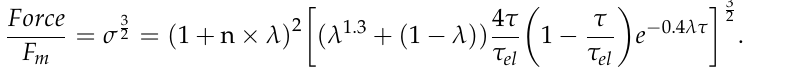
Figure 9. ( a ) Force–time collision curves of the equation established in this study and that of the Zener standard; ( b ) Force–time collision curves of the equations established by Boettcher et al. and Zener standard [2,12]. 4. Conclusions The nonlinear collision motion equation proposed by Zener [2] is the force–time col- lision curve of the inelasticity parameter ( 0 (cid:3409) λ (cid:3409) 1.5 ) considered in the collision process through numerical analysis. In this study, we have proposed an approximate solution to Zener’s inelastic collision theory, which is expressed as (cid:3007)(cid:3042)(cid:3045)(cid:3030)(cid:3032) (cid:3007) (cid:3288) = σ (cid:3119) (cid:3118) = (1 + 0.2λ) (cid:2870) (cid:4674)(λ (cid:2869).(cid:2871) + (1 − 𝜆)) (cid:2872)(cid:2980) (cid:3099) (cid:3280)(cid:3287) (cid:4672)1 − (cid:3099) (cid:3099) (cid:3280)(cid:3287) (cid:4673)𝑒 (cid:2879)(cid:2868).(cid:2872)(cid:3090)(cid:3099) (cid:4675) (cid:3119) (cid:3118) . The contribution of the present study to literature includes an approximate solution that is simple and can be used directly without complex calculations. The contact time, magnitude of the material impact force and displacement, and inelasticity parameter can